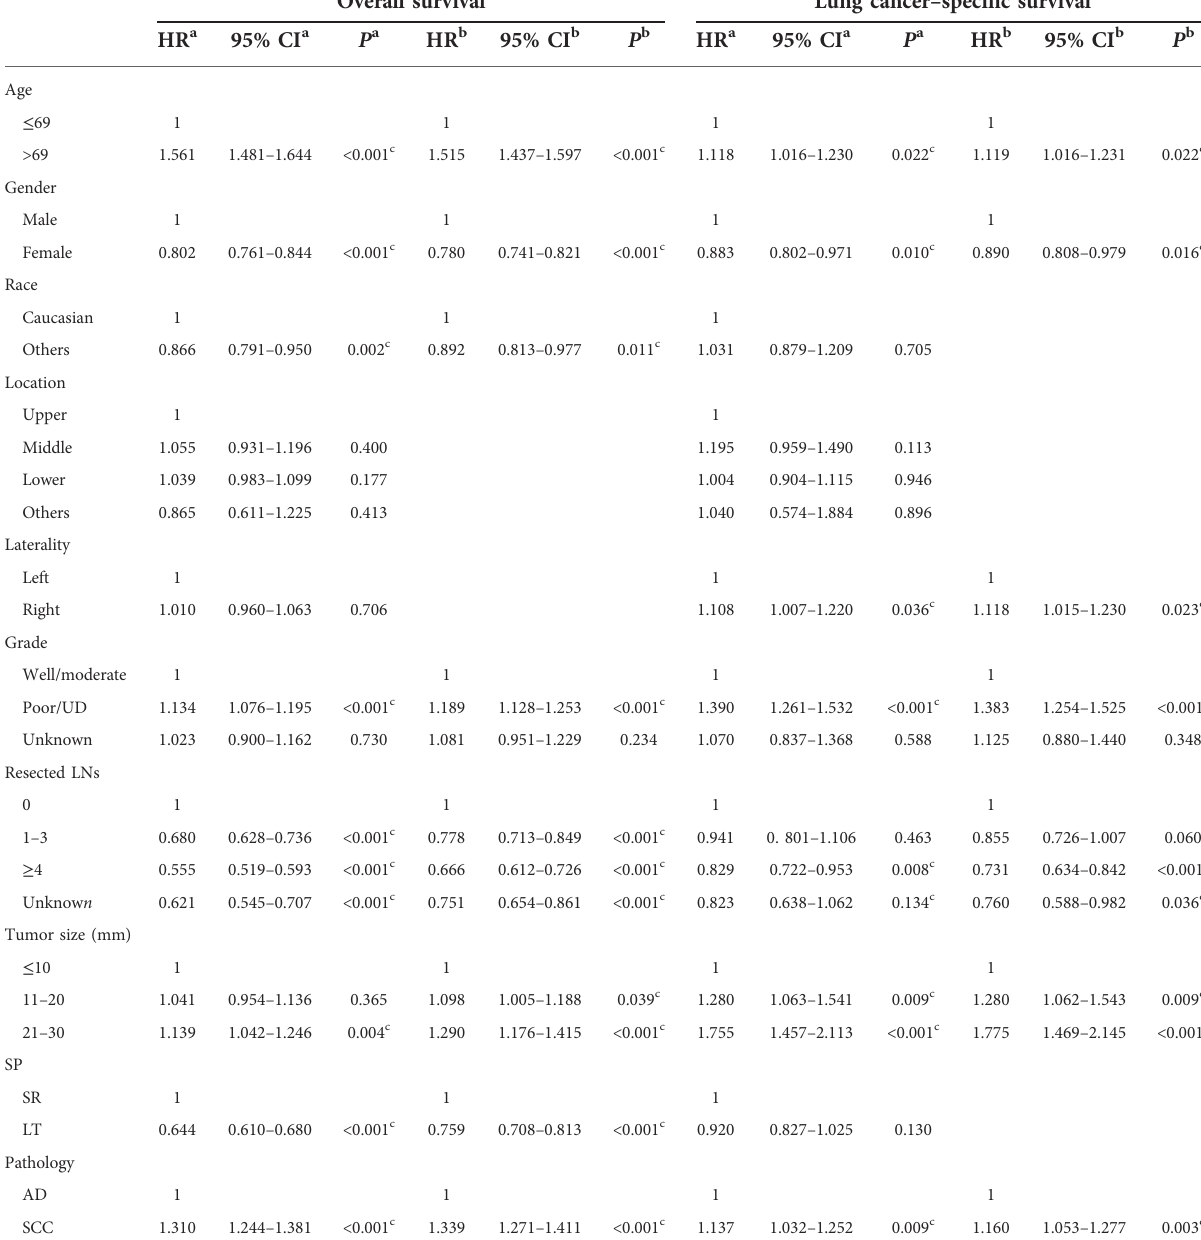
TABLE 3 Univariate and multivariate regression analyses for overall survival and lung cancer – speci fi c survival after